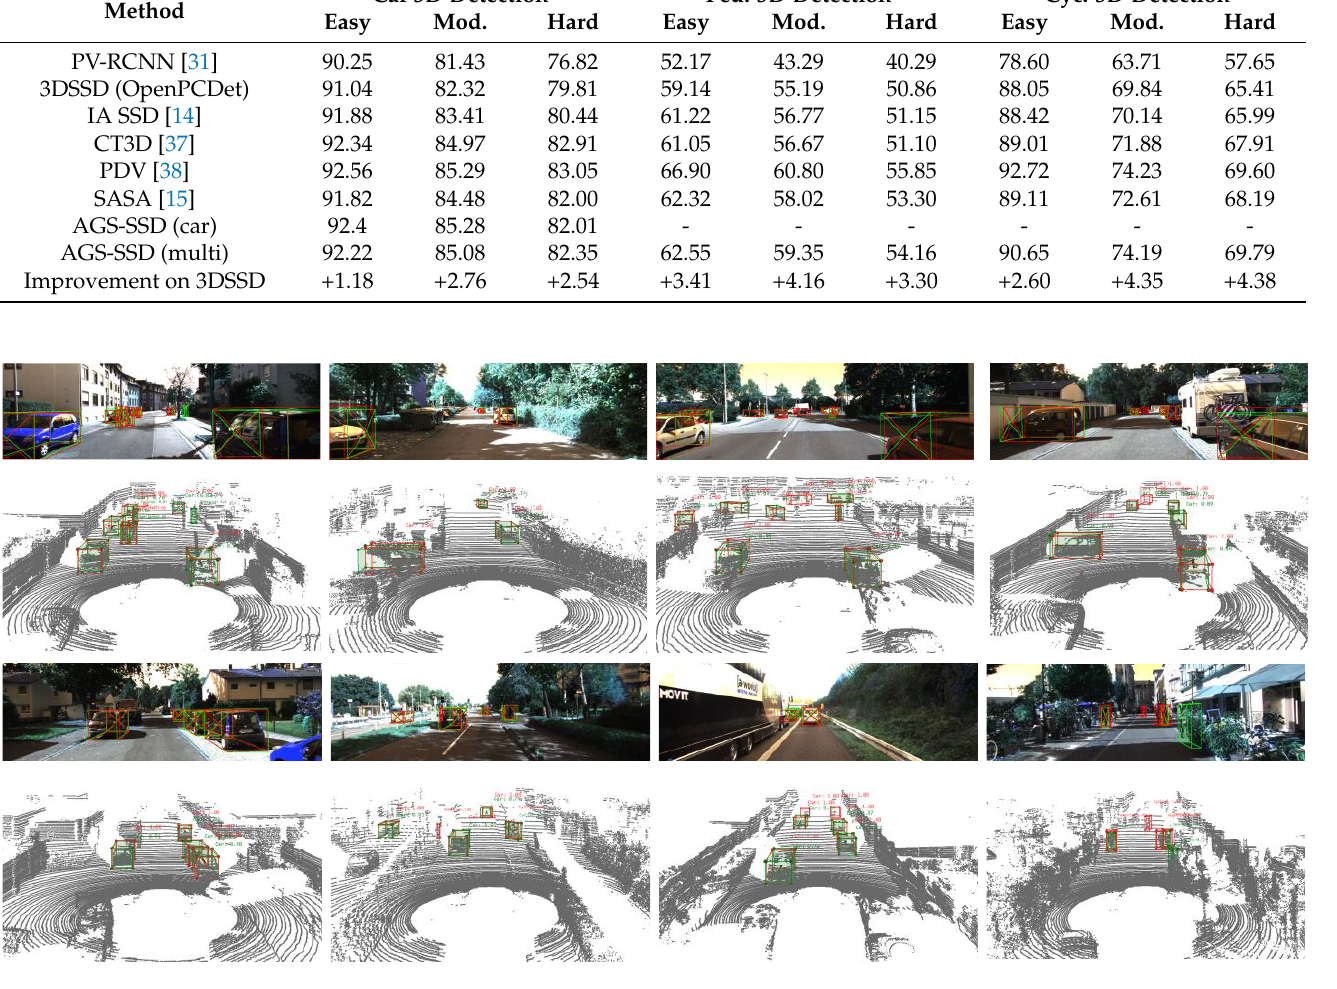
Figure 6. Qualitative results achieved on the KITTI val set. Red boxes represent the ground truth. Green boxes denote the prediction results. The numbers in green represent the confidence of the prediction. Table 3. Performance of proposed method with different configurations on KITTI val set. The results are evaluated with the average precision calculated based on 40 recall positions.